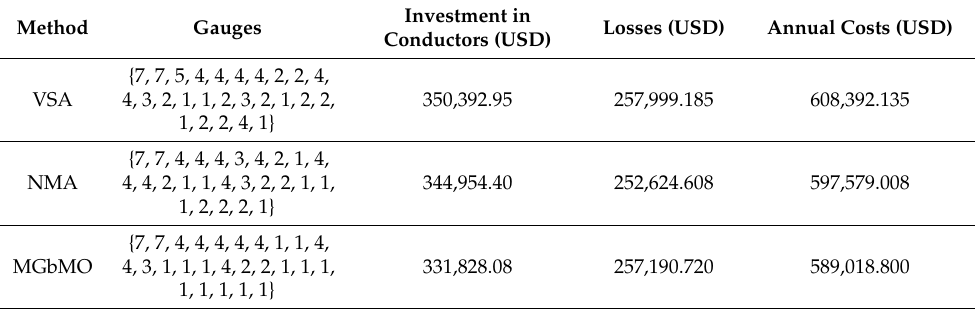
Table 12. Numerical results for the IEEE 27-bus system